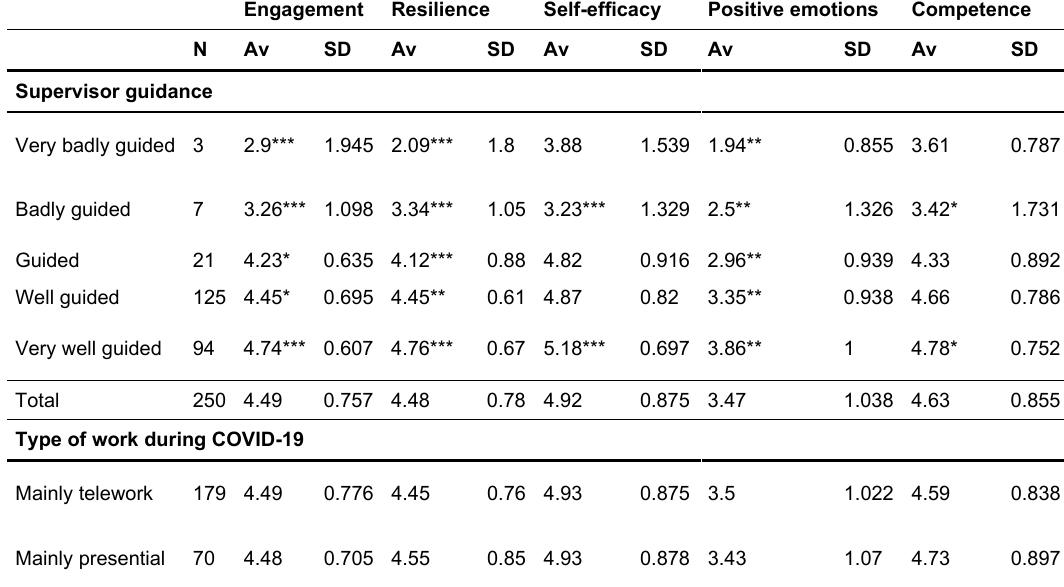
Table 5. Employee strengths according to supervisor guidance and type of work during COVID-19. Engagement